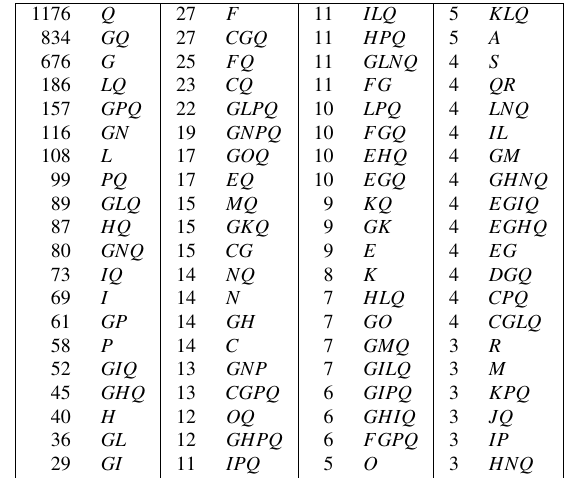
Table 1. The most commons user profiles generated with thresh- old t =